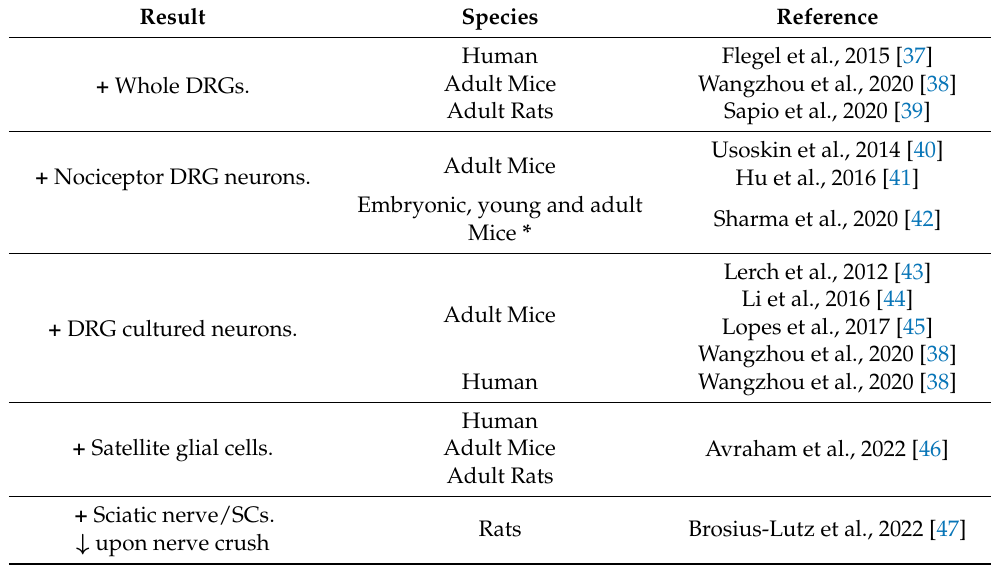
Table 1. Expression of GPM6a’s mRNA in the DRG and other PNS-derived tissues and cells from mice, rats and humans. Bioinformatic analysis of GPM6a’s gene expression from bulk or single-cell RNA-seq from public datasets. All DRGs samples or cultured neurons were localized to the lumbar area with the exception of those reported by Sharma et al. 2020, which did not specify the anatomical locatiosn of the samples. * Sharma et al. 2020 analyzed DRGs at different stages of development: E11.5, E12.5, E15.5, P0, P5 and P28-42. + : Expression of GPM6a gene in the indicated samples. Downward arrow means downregulation of the GPM6a transcript. DRG: dorsal root ganglia, SCs: Schwann cells, E: embryonic day, and P: postnatal